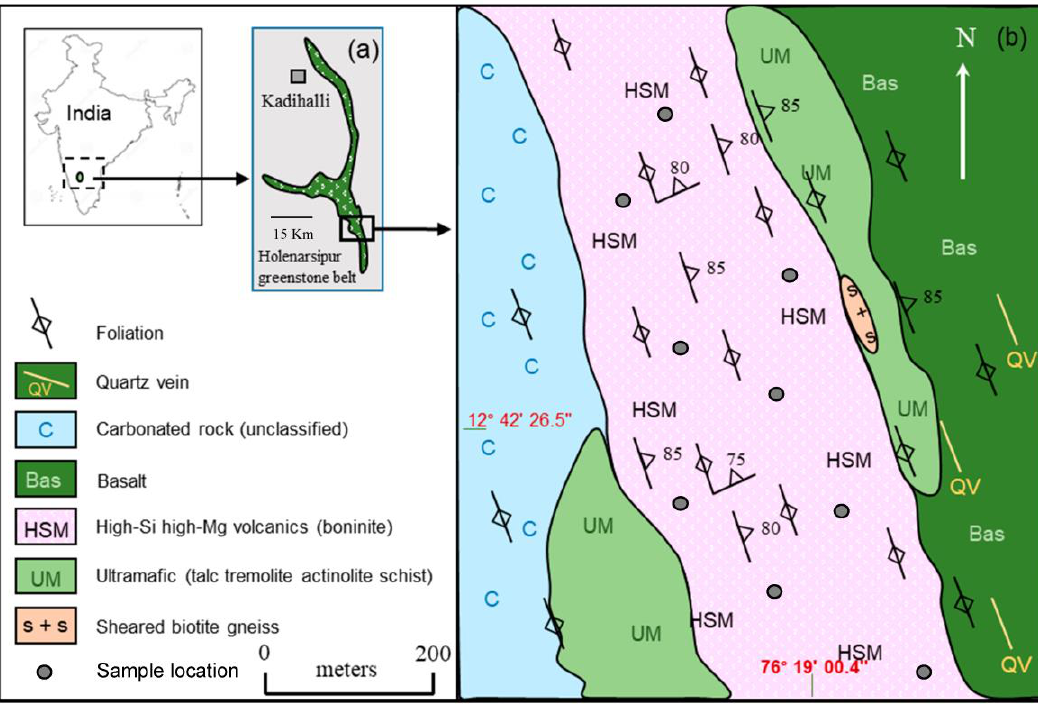
Figure 1. An outline map of India showing: ( a ) the location of the Holenarsipur greenstone belt in the western Dharwar craton; and, ( b ) detailed geological map of the study area located in the south of the Holenarsipur greenstone belt.